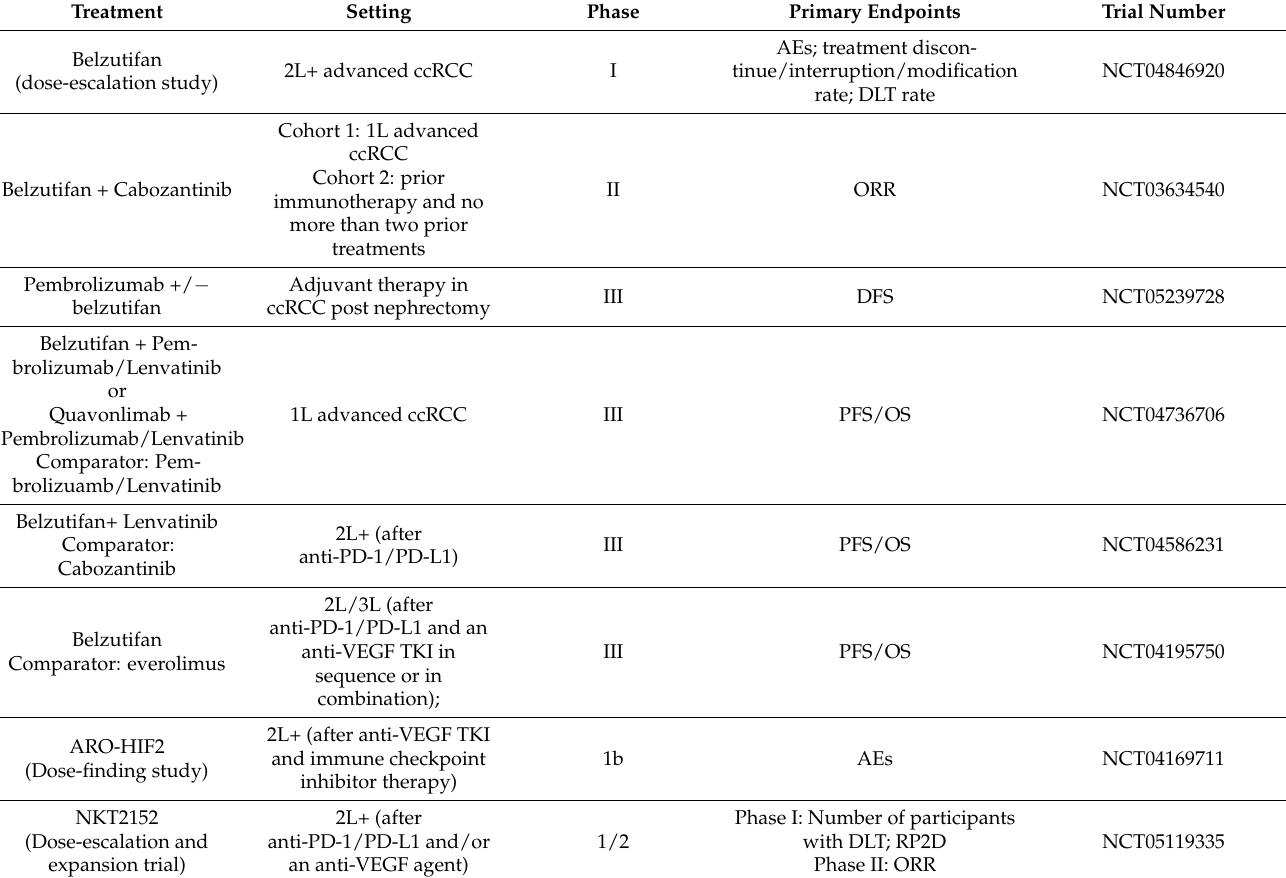
Table 1. Ongoing clinical trials of HIF